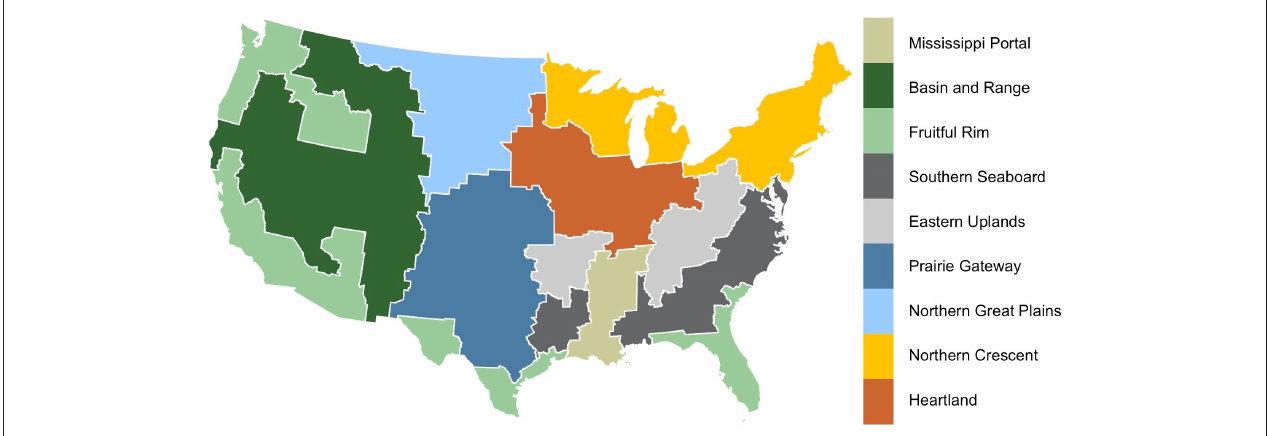
FIGURE 1 | Farm Resource Regions (FRRs) across the U.S., determined by crop production type, amount, and value.